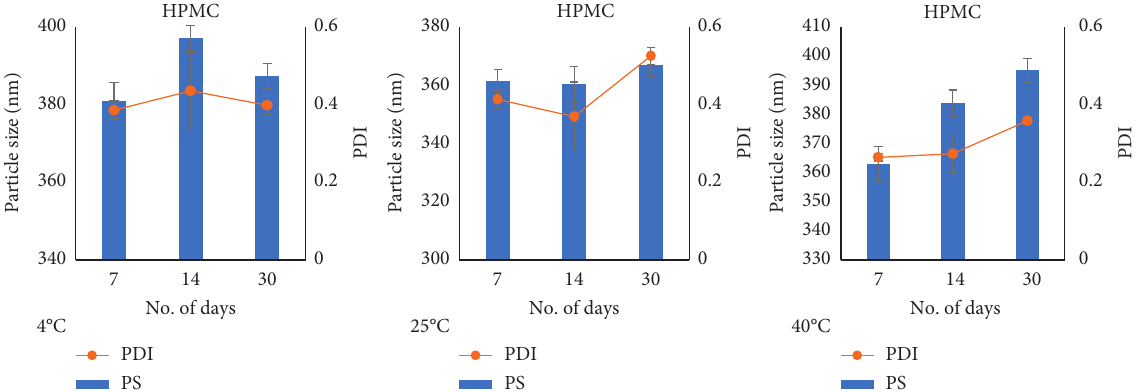
Figure 3: Stability profile of the HPMC-stabilized naringenin nanosuspension as a function of number of days at different storage temperatures (after 15 homogenization cycles, pressure 1500bar and n � 3).